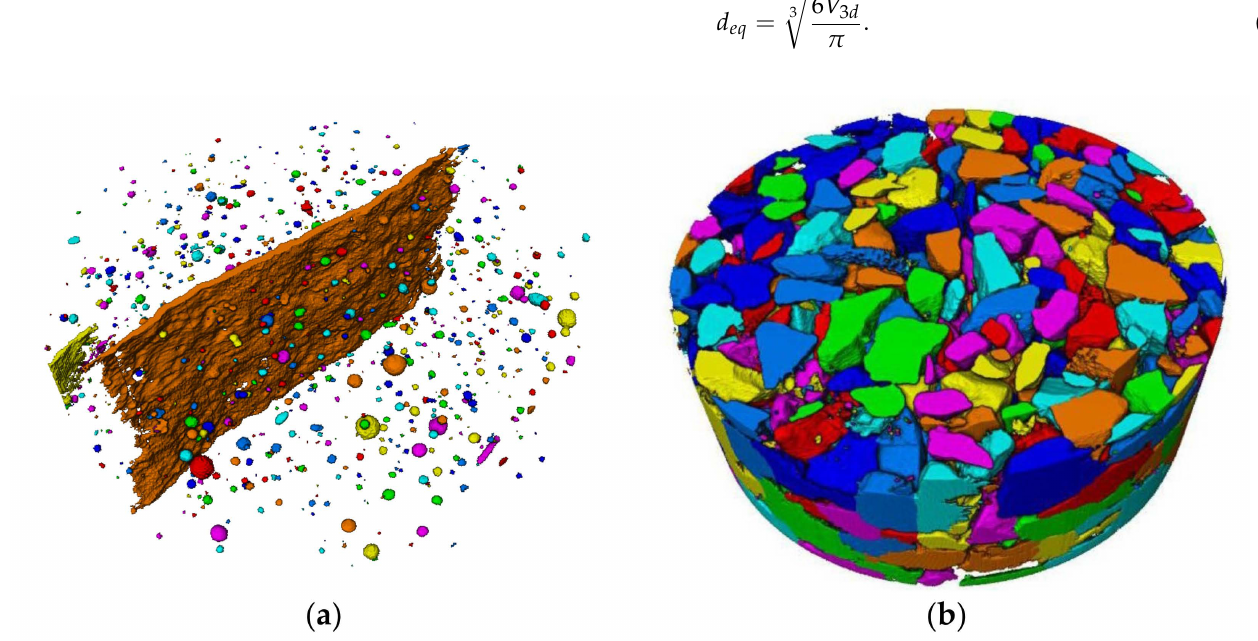
Figure 15. Separation results: ( a ) results of mortar pore separation; ( b ) results of aggregate separation.